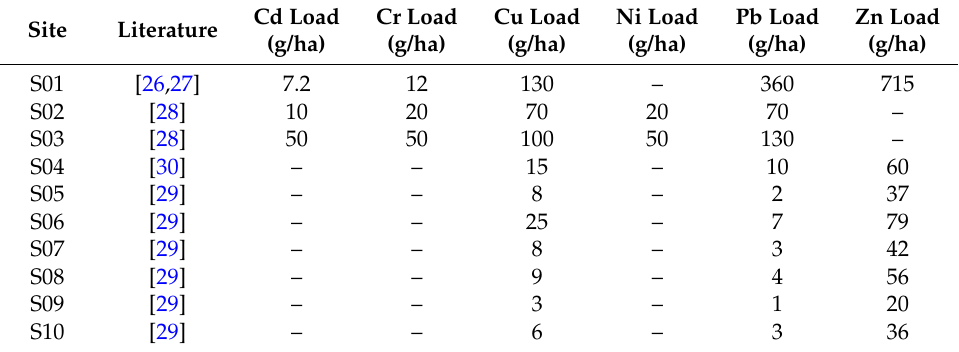
Table 4. Annual total heavy metal loads in pre-treated runoff from traffic